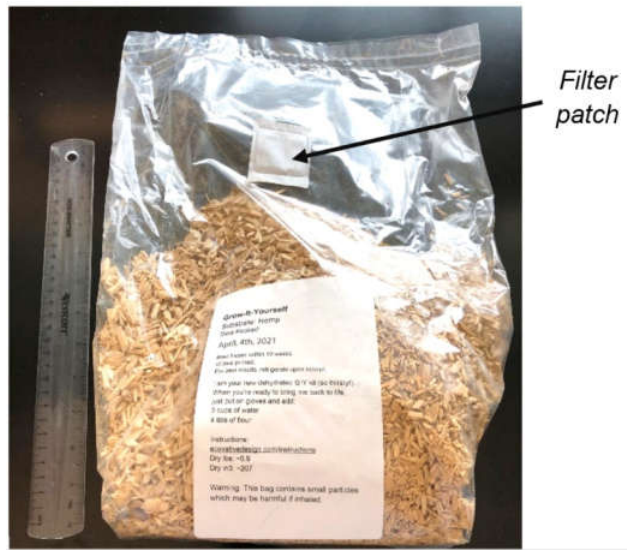
Figure 1. As-received biomass–fungi material in a filter patch bag.